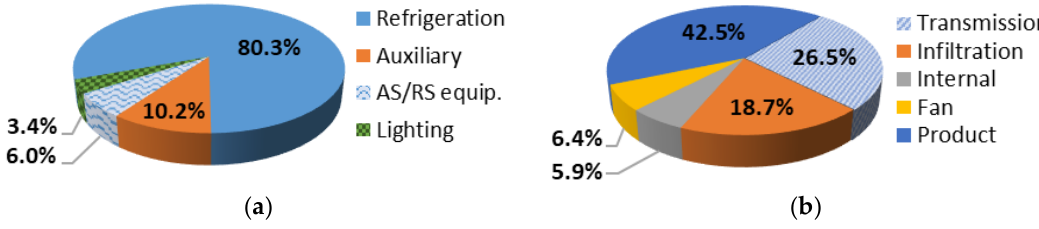
( b ) Figure 6. Optimal solution minimizing grid electricity demand: yearly cost structure ( a ) without and ( b ) with PV plant. Figure 7a shows the structure of the electricity demand for the optimal solution minimizing grid electricity and using a PV plant. Compared to the optimal solution minimizing total cost and